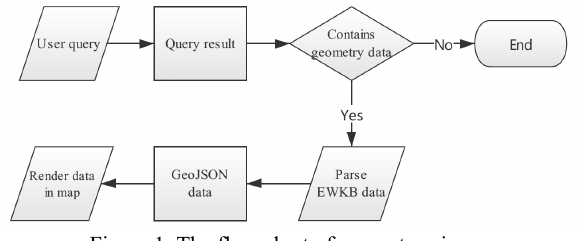
Figure 1. The flow chart of geometry